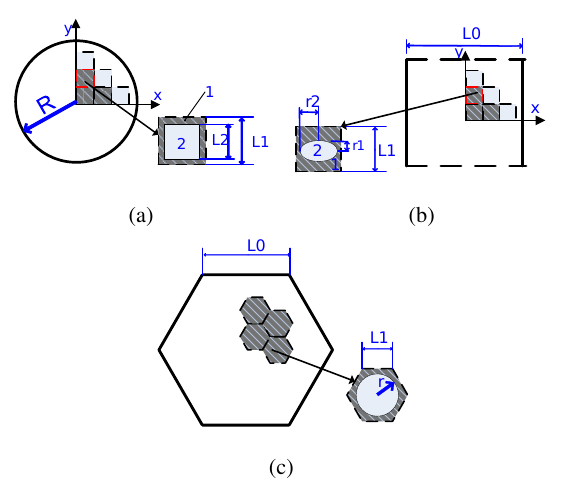
Figure 5: Three configurations components of SMC to im- plement homogenization model.